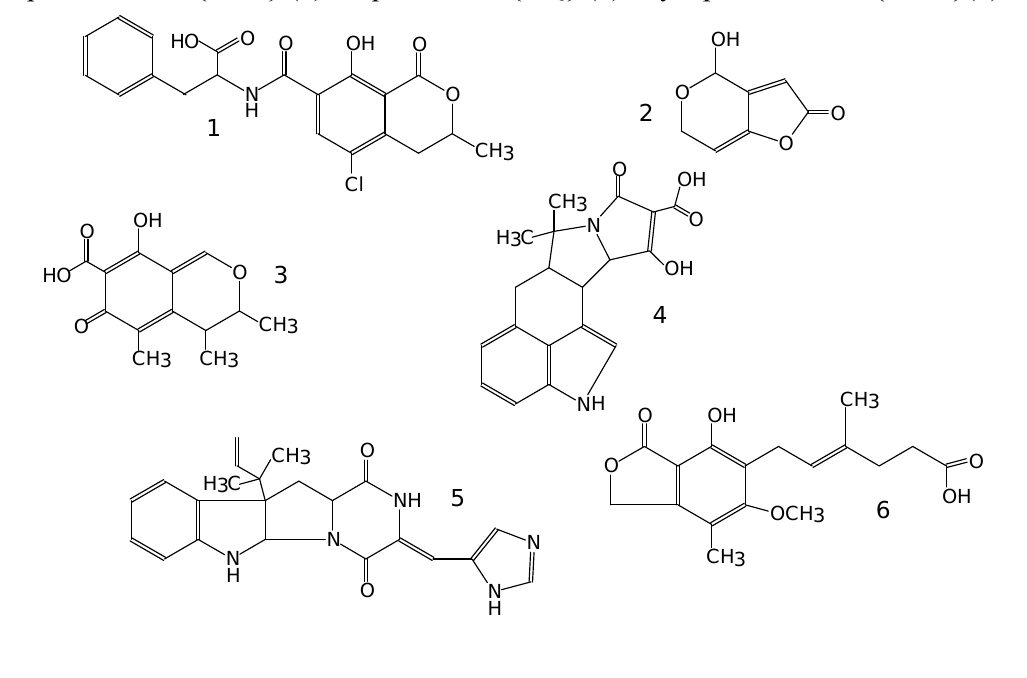
Figure 6. Structures of some important mycotoxins produced by Penicillium and Aspergillus species: ochratoxin A {OTA}(1), patulin {PAT}(2), citrinin {CIT} (3), cyclopiazonic acid {CPA} (4), roquefortin C {RQ} (5), mycophenolic acid